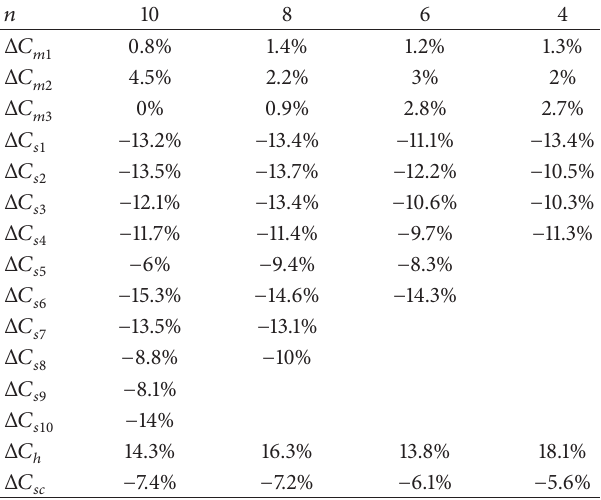
Table 5: The change of every cost item when 𝑚 = 3